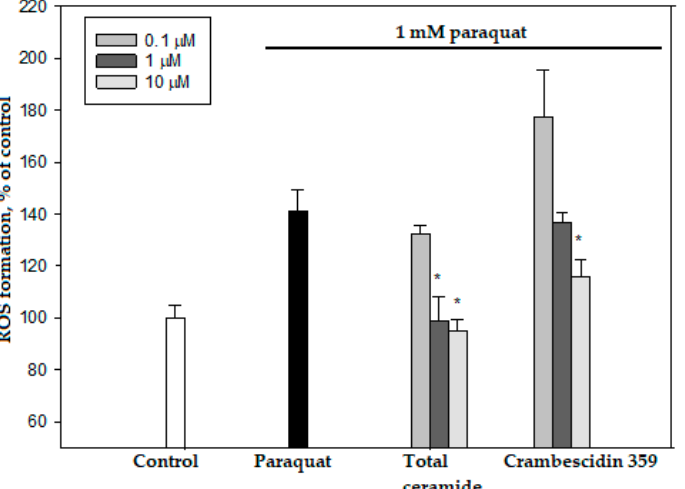
Figure 6. Effects of total ceramide and crambescidin 359 on ROS formation in Neuro-2a cells. The data are presented as m ± se ( n = 3). * p < 0.05 compared to cells exposed to paraquat alone.